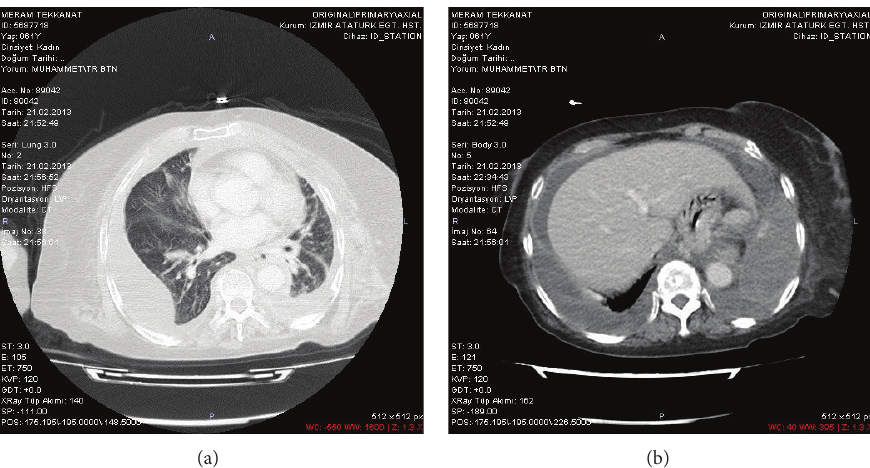
Figure 1: (a) A chest CT scan revealed bilateral pleural effusion with a partial compression at the left lung. (b) An abdomen CT scan revealed large amount of ascites of chylous